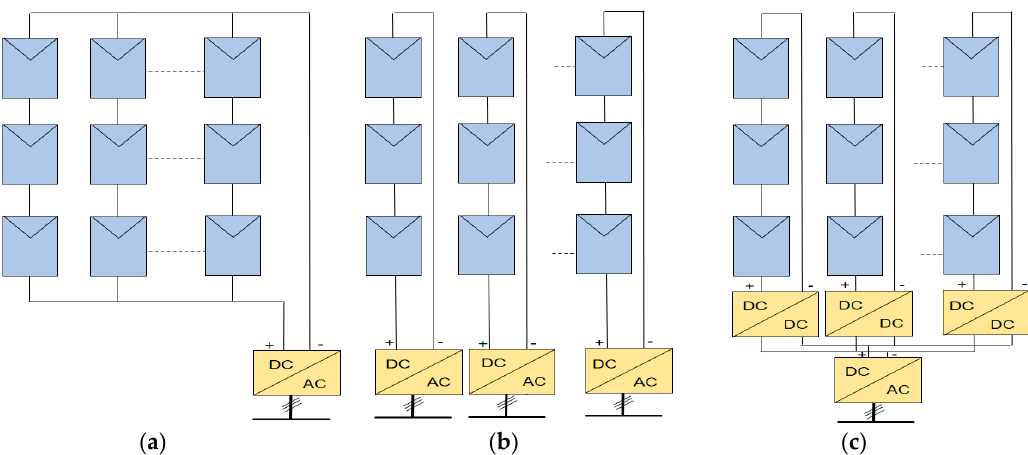
Figure 1. Different configurations for PV inverter topologies. ( a ) Central, ( b ) string, ( c ) multi-string. The internal topology of a PV power plant represents the electrical connections among PV panels, PV inverters and transformers. Different topologies and configurations could be considered based on output power, cost, and reliability such as central topology, string topology and multi-string topology. There are different configurations for connecting the internal DC collection grid and the AC collection grid, such as radial, star, and ring [4,5].